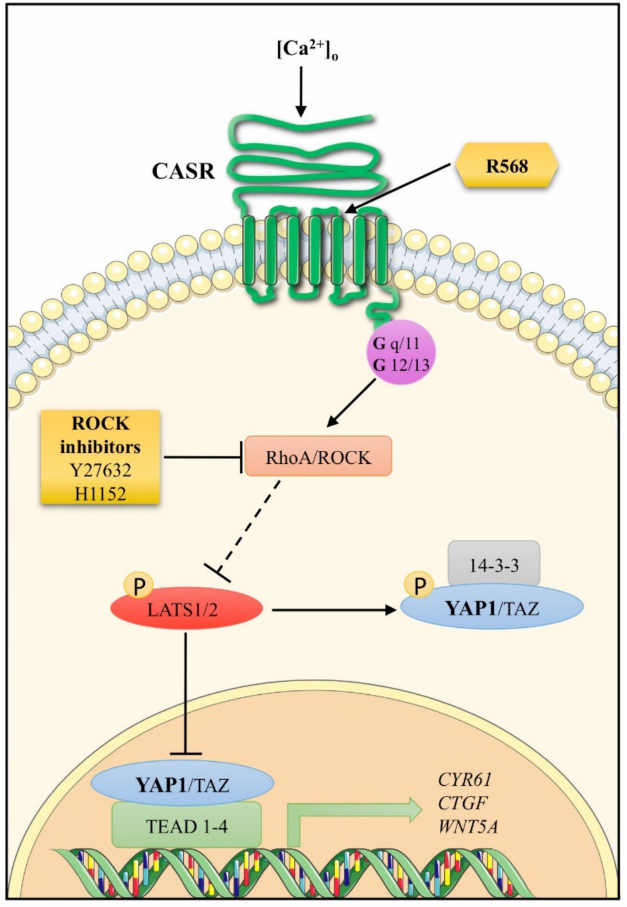
Figure 8. Schematic representation of the CASR-ROCK-YAP1 signaling pathway in tumor parathy- roid cells. Stimulation of the calcium-sensing receptor with Ca 2+ or R568 through the coupling with G α 12/13 or G α q/11 leads to activation of small GTPase protein RhoA, which indirectly in- hibits LATS kinase activity. LATS1/2 phosphorylates YAP1 on highly conserved residues of ser- ine. The phosphorylation of YAP1 promotes cytoplasmic retention and degradation. However, when RhoA inhibits LATS1/2, dephosphorylated YAP1 translocates into the nucleus, where it binds and activates TEAD transcription factors, inducing the expression of multiple genes. Part of this figure was created with images from Servier Medical Art (http://smart.servier.com/,